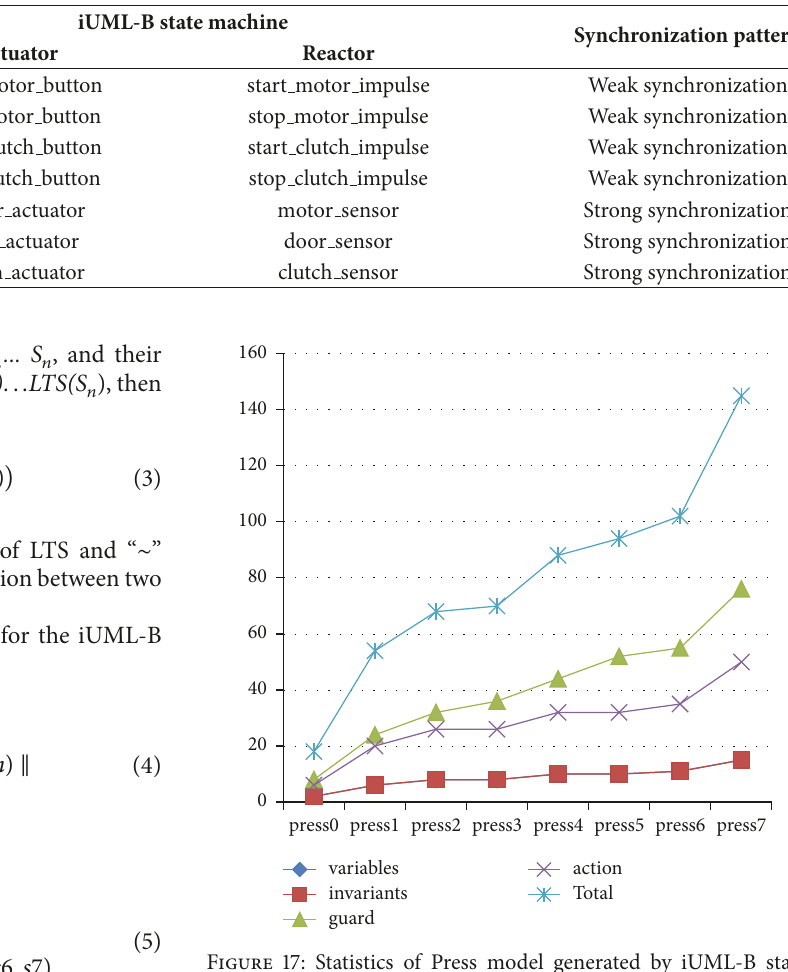
Table 1: Subsystems of Press system and its corresponding iUML-B state machines.